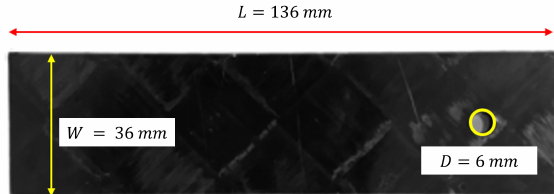
Figure 2. Sample’s dimensions for double-lap bolted joint.